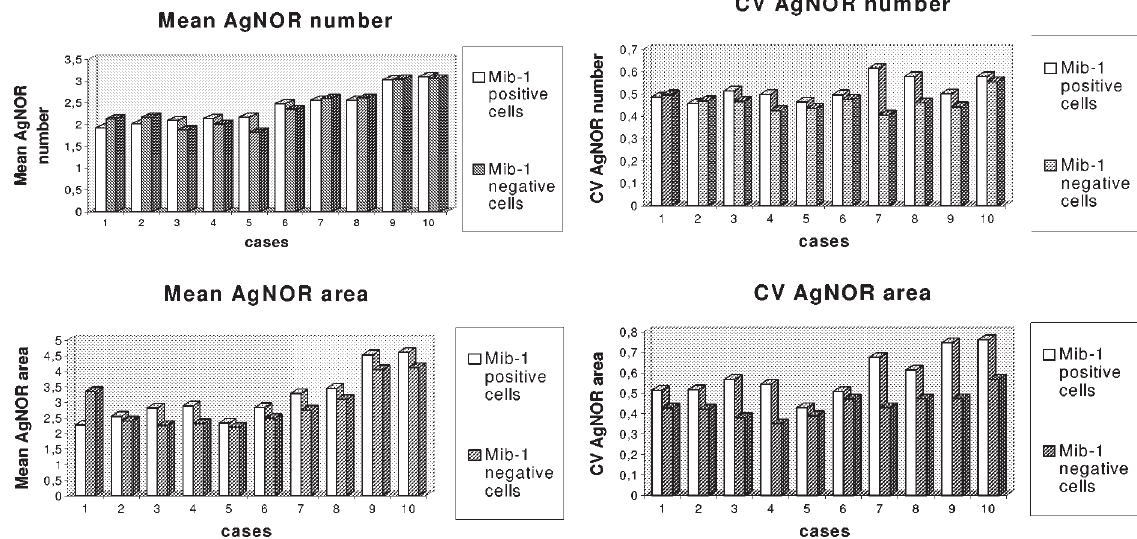
Fig. 5. Statistical distribution of standardised AgNOR parameters in MIB1 positive and MIB1 negative tumour cells in 10 invasive ductal carcinomas investigated by double